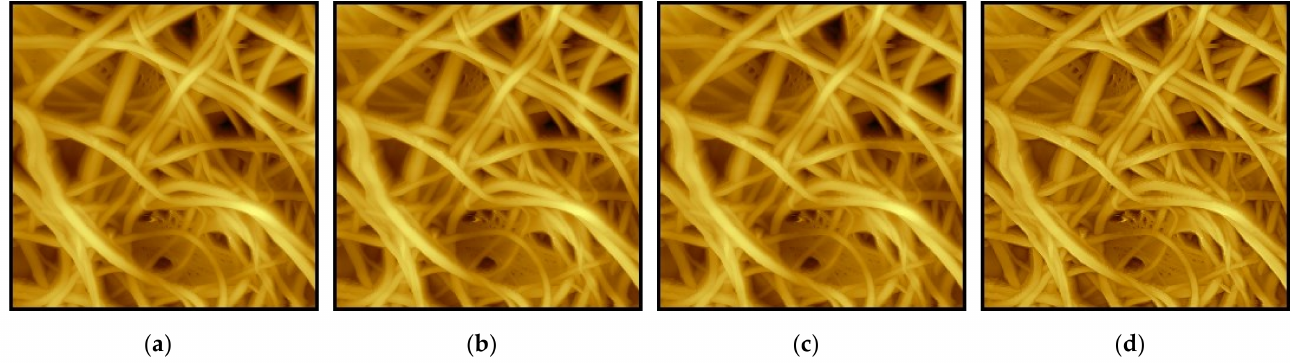
Figure 2. Post-treatment steps, performed on sample a : ( a ) polynomial background subtraction; ( b ) aligning rows; ( c ) deleting horizontal errors; ( d ) sharpening